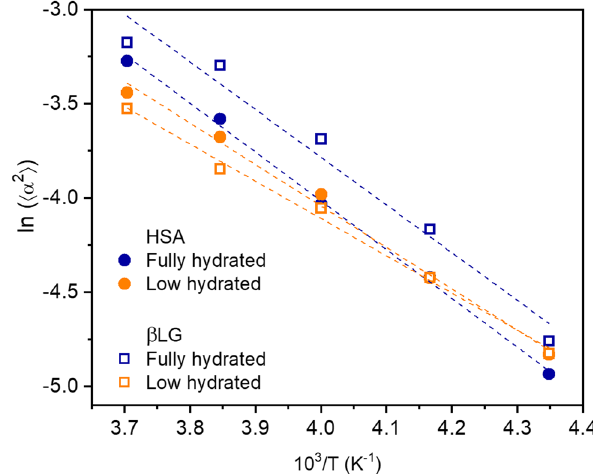
Figure 5: Arrhenius plots characterizing the temperature depen - dence of the librational amplitude, 〈 α 2 〉 , in the high temperature regime for β LG and HSA at di ff erent hydrating conditions. Dashed lines are linear regressions of the